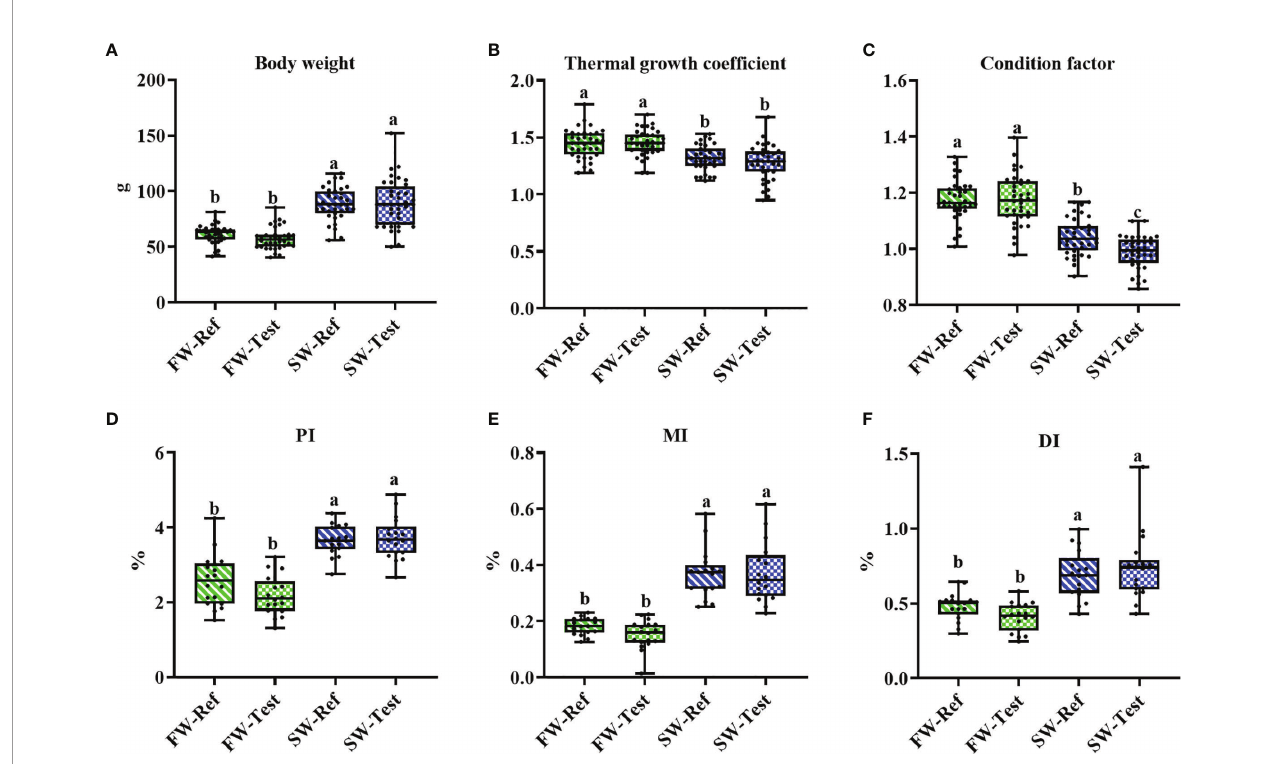
FIGURE 1 | The growth performance (A, B) , condition factor (C) and intestinal indices (D – F) of Atlantic salmon among treatments. Different letters among groups denote signi fi cant differences (p < .05) and values sharing the same letters are not signi fi cantly different. PI, proximal intestine; MI, mid intestine; DI, distal